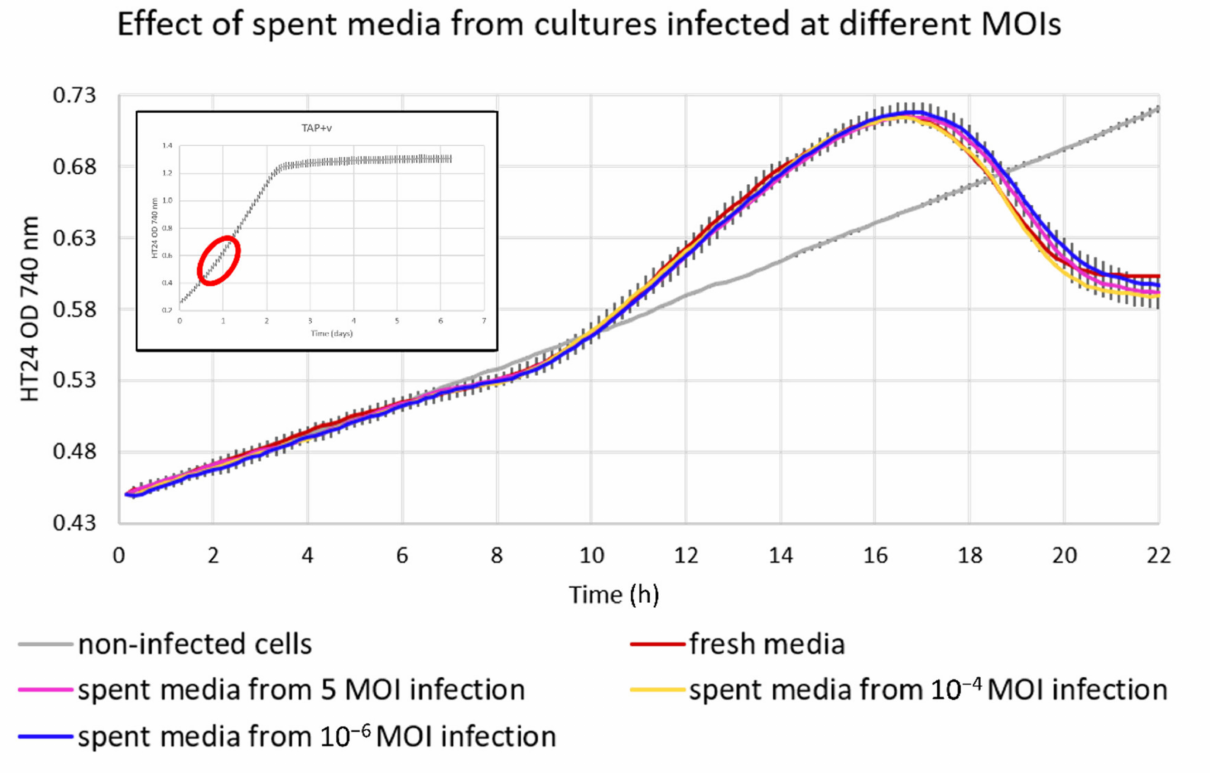
Figure 6. Infection of Chlorella variabilis cultures at 10 − 4 MOI with CviKI virus isolate and spent media from cultures infected at different MOIs, including a noninfected control. Cells were resuspended in fresh TAP medium for the no signalling molecules condition and with filtered spent medium for the other conditions as explained in the Materials and Methods section. The values are the average of 3 biological replicates with standard deviations. The inset graph from Figure 1 on the top left corner is used to highlight the scale of the closeup graph compared to the full growth of the uninfected organism, underlining that these are the fine-scale data focused on the initial part of the exponential